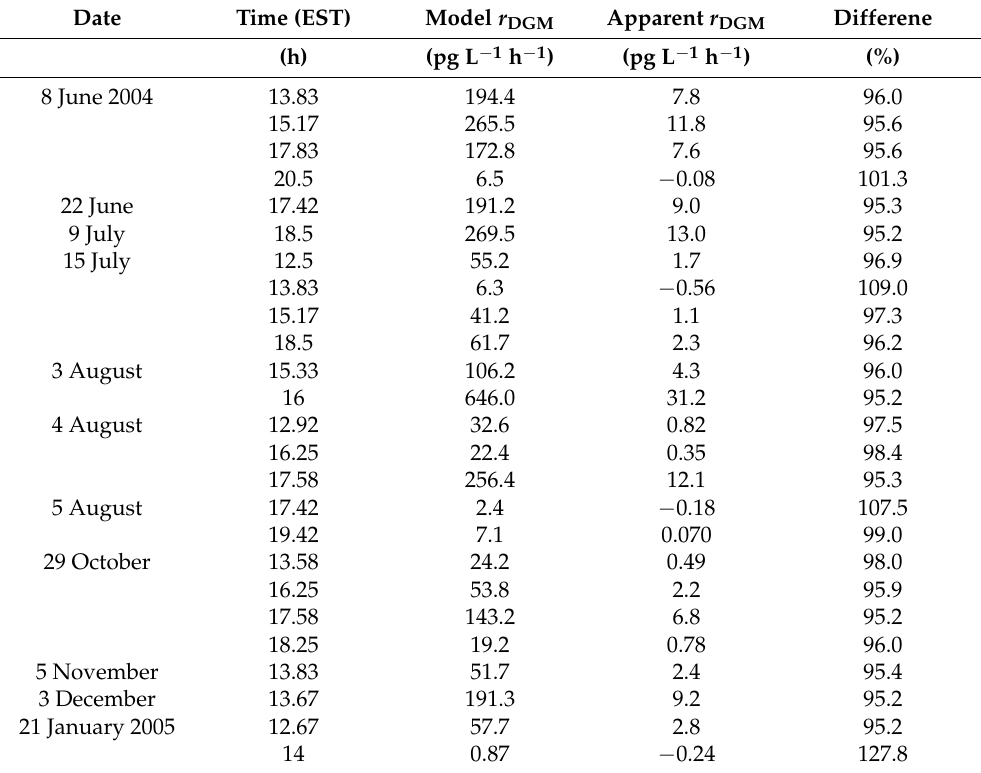
Table 4. A comparison of the model-calculated rates with the apparent rates of DGM